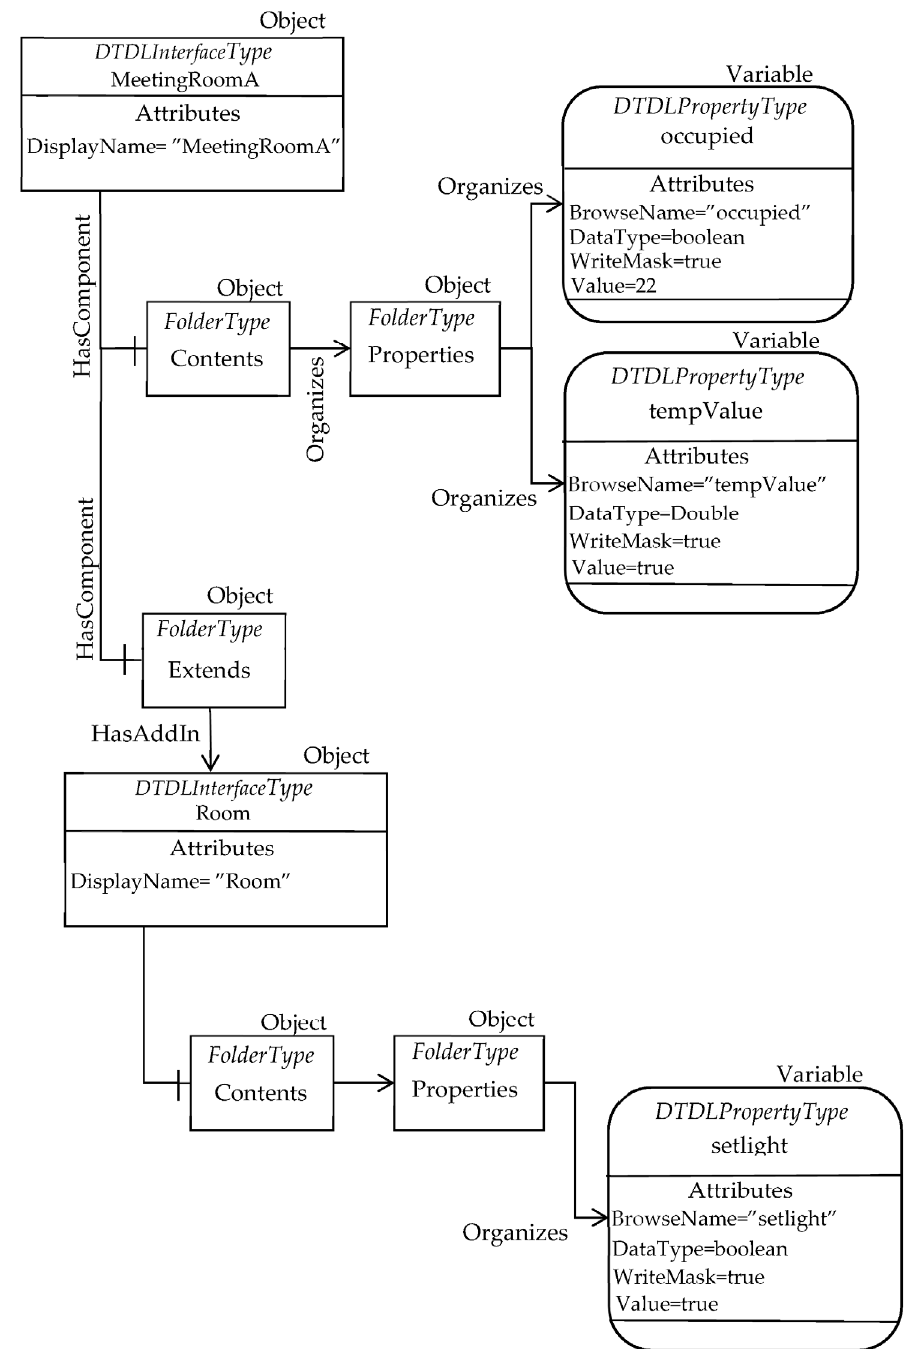
Figure 13. Example of mapping using the OPC UA DTDL InterfaceType.